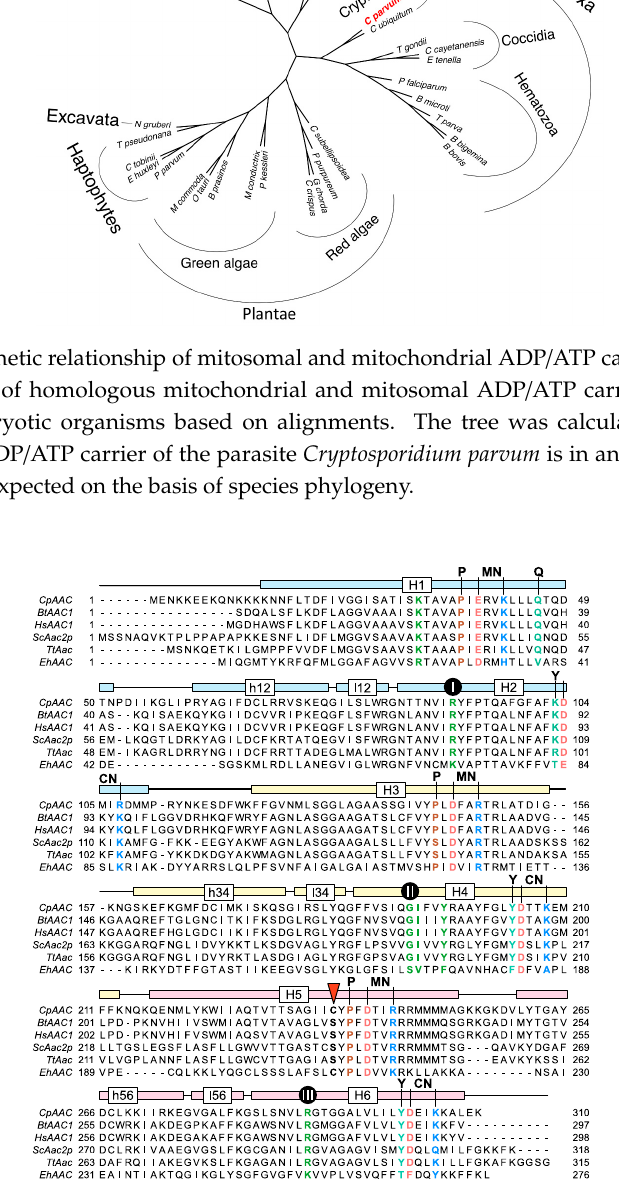
Figure 3. CpAAC has all of the key features of a functional ADP/ATP. Structural models of CpAAC, in the cytoplasmic state ( left ) and matrix state ( right ), based on Protein Data Bank (PDB) entries 4c9g